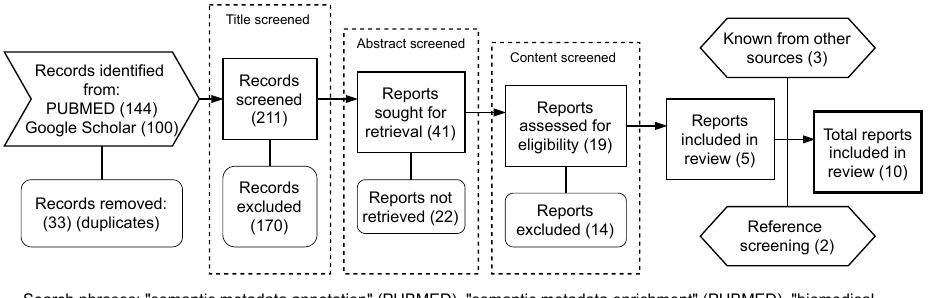
Figure 2. The flow diagram illustrates the selection process at the various stages of the systematic review. It maps out the number of records identified from databases and included or excluded from the review. It is based on the PRISMA 2021 flow diagram